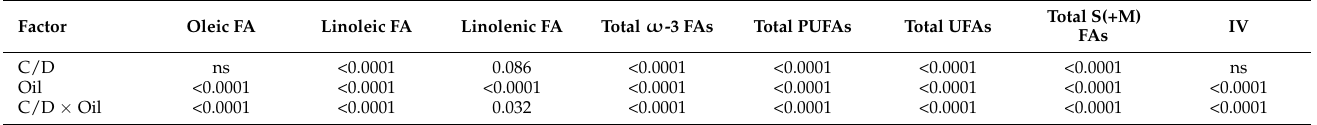
Table 6. Statistical significance of main factors (continuous (C) versus discontinuous (D) thermal- stressing methods (C/D), oil type, and their first-order interaction effect, obtained from an ANOVA analysis of the FA composition and IV dataset (Model 2).